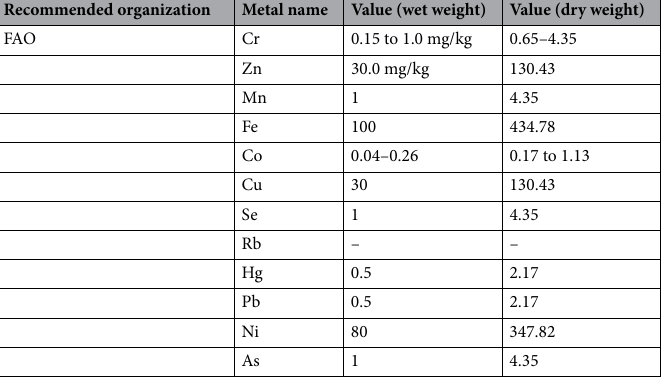
Table 4. Approximate value of dry weight converted from the wet weight recommended by FAO 48